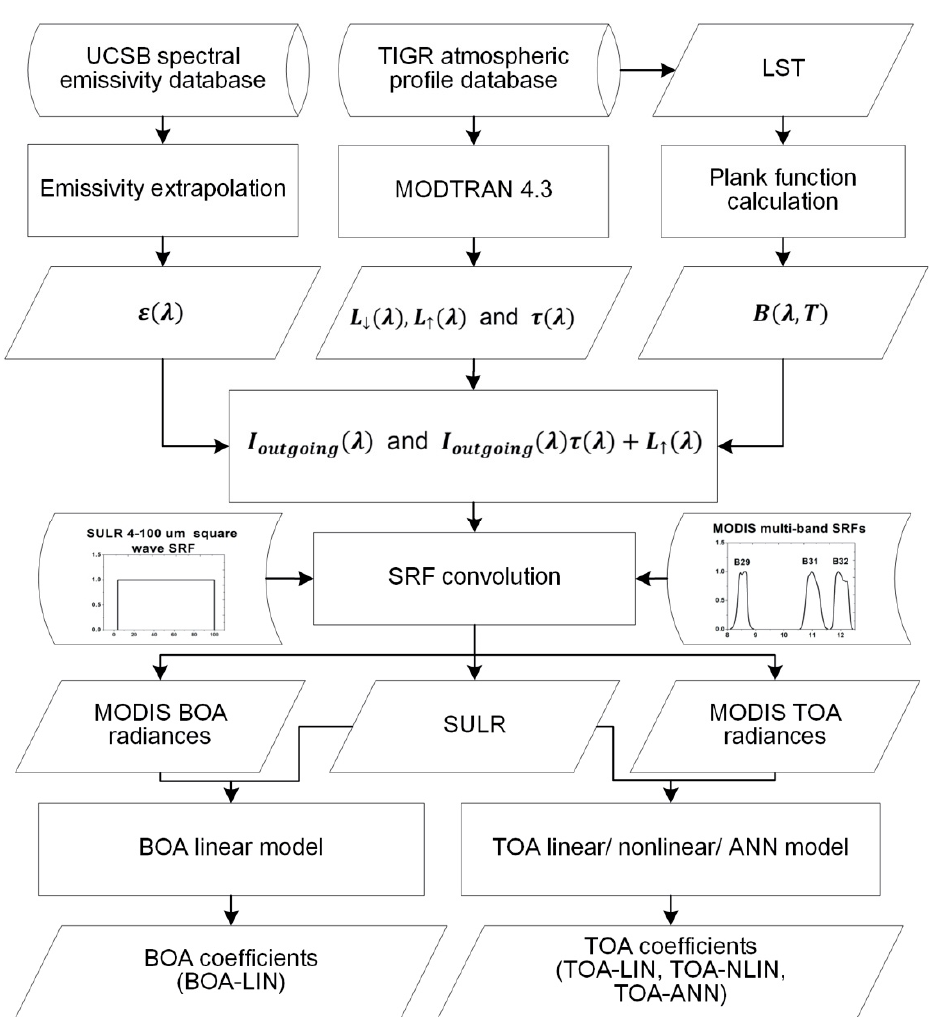
Figure 2. The flowchart of the coefficient estimation for the hybrid methods.